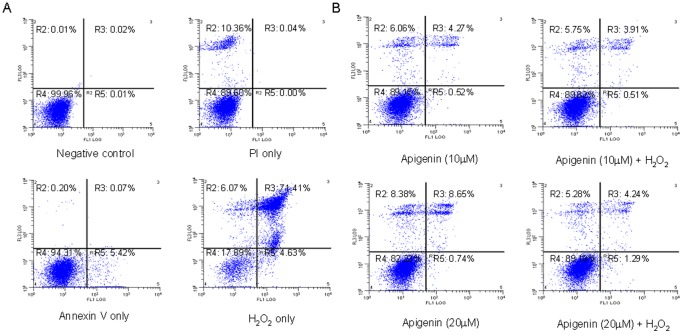
Effect of apigenin on H2O2 -mediated RWPE-1 cell death.(A) Effect of H2O2 on cell death in RWPE-1 cells. The cells were treated with 200 µM H2O2 for 6 h. Negative, PI and annexin V only treatments are included as controls. (B) Cells were treated with 10 µM and 20 µM concentration of apigenin for 16 h followed by 200 µM H2O2 incubation for 6 h, stained with PI and annexin V for 15 min and analyzed using fluorescence activated cell sorter (FACS). Data shown is representation of FACS graphs analyzed two times in duplicate. Details are described in materials and methods section.